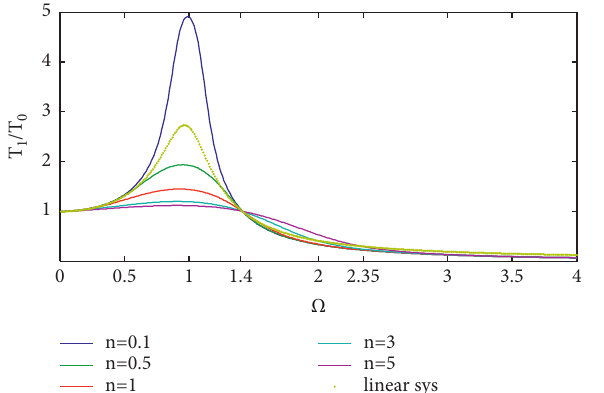
Figure 9: Force transmissibility-frequency ratio diagram for dif- ferent relative damping coefficient.